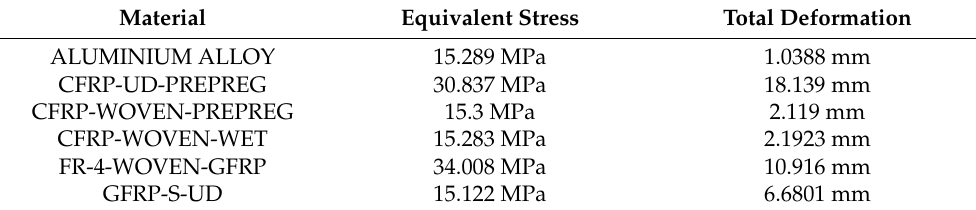
Table 4. Comparative structural outcomes under VTOL